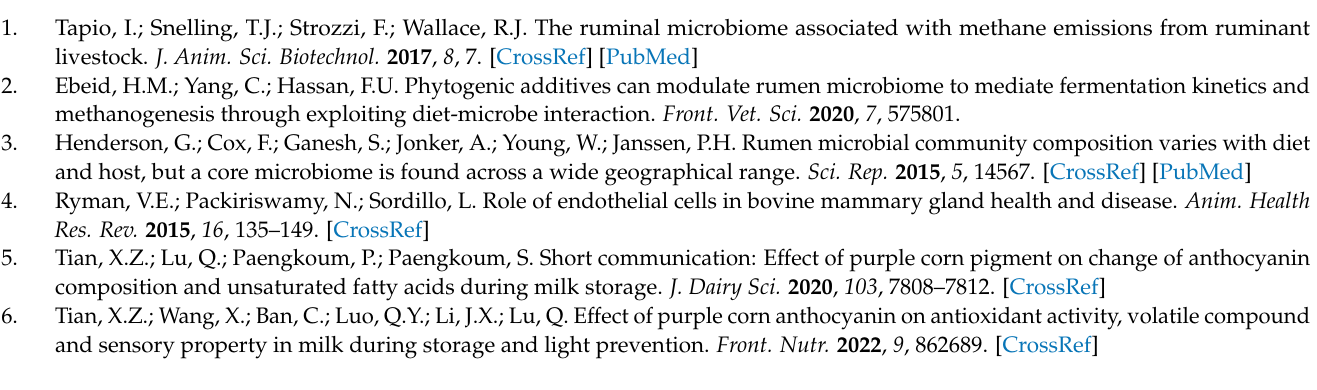
Figure S2: Comparison of microbial domains among the three groups; Figure S3: The percent of community abundance on phylum level; Figure S4: The percent of community abundance on genus level; Figure S5: The percent of community abundance on species